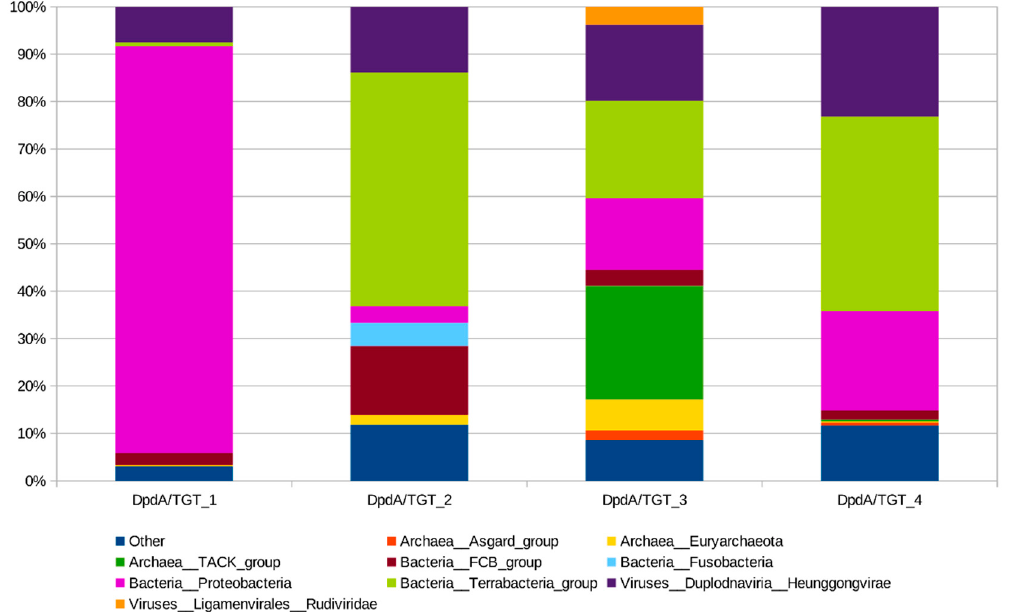
Figure 6. Taxonomic analysis of the largest CLANS groups. Y and X axes show abundance of a specific taxon and largest DpdA/TGT groups, respectively.